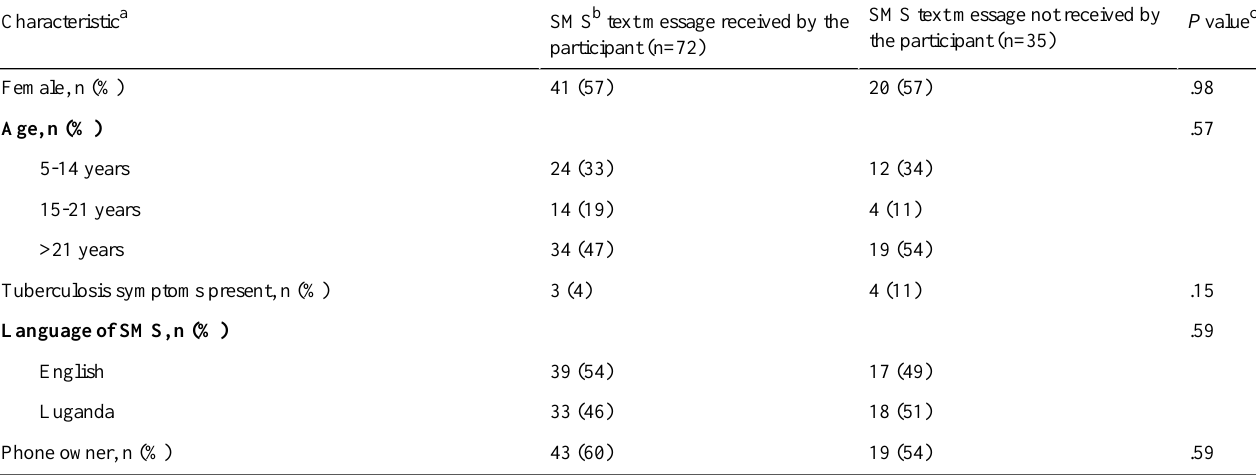
Table 1. Demographic characteristics of participants, stratified by whether the short message service was received by the